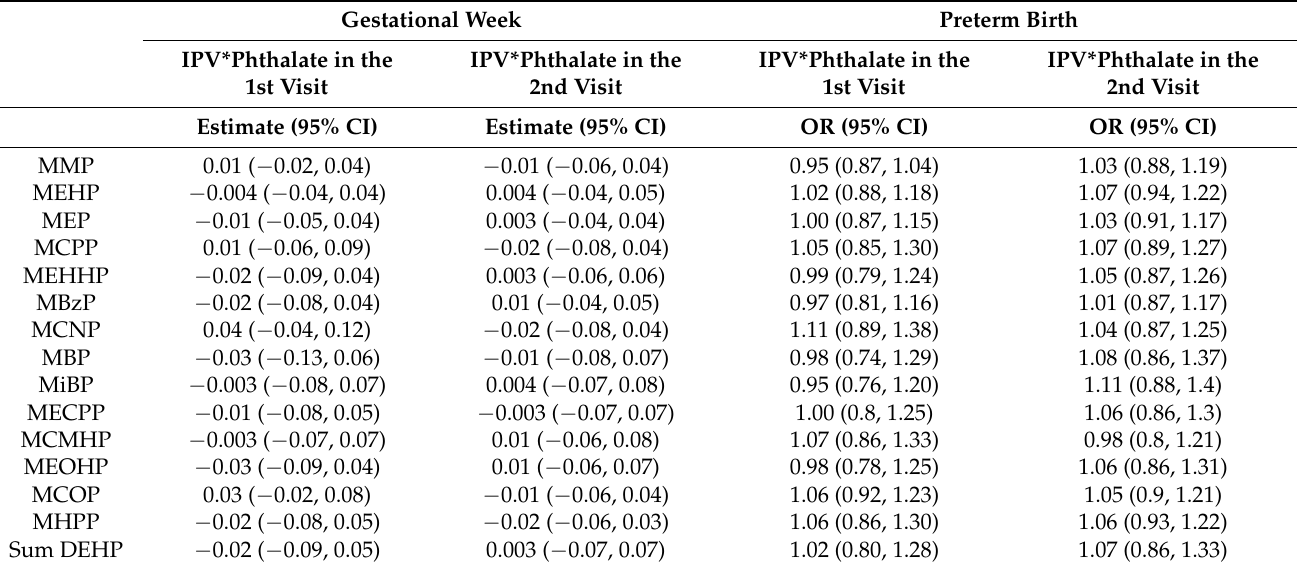
Table A4. Estimated effects of the interaction between Intimate partner violence and individual phthalates in each visit in CANDLE participants with a spontaneous